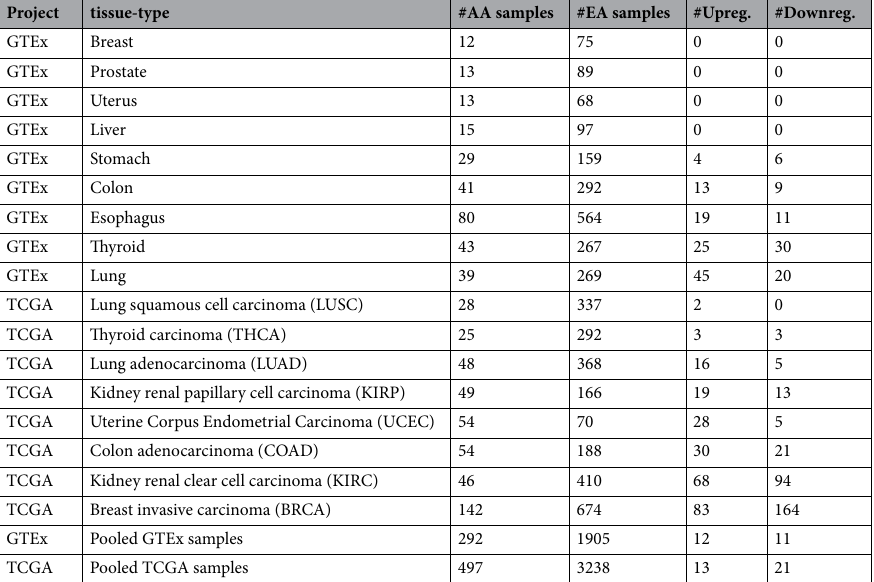
Table 1. Number of DE genes in African Americans (AA) compared to European Americans (EA) in nine non-diseased tissue types and eight tumor types. Only tissue-types with AA sample size 12 or greater are shown. Samples are sorted first by project, and then by the number of upregulated genes. The number of samples affects the power of the DE test. Criteria for DE:>2-fold difference in expression based on Mann– Whitney U test (BH-corrected p value < 0.05